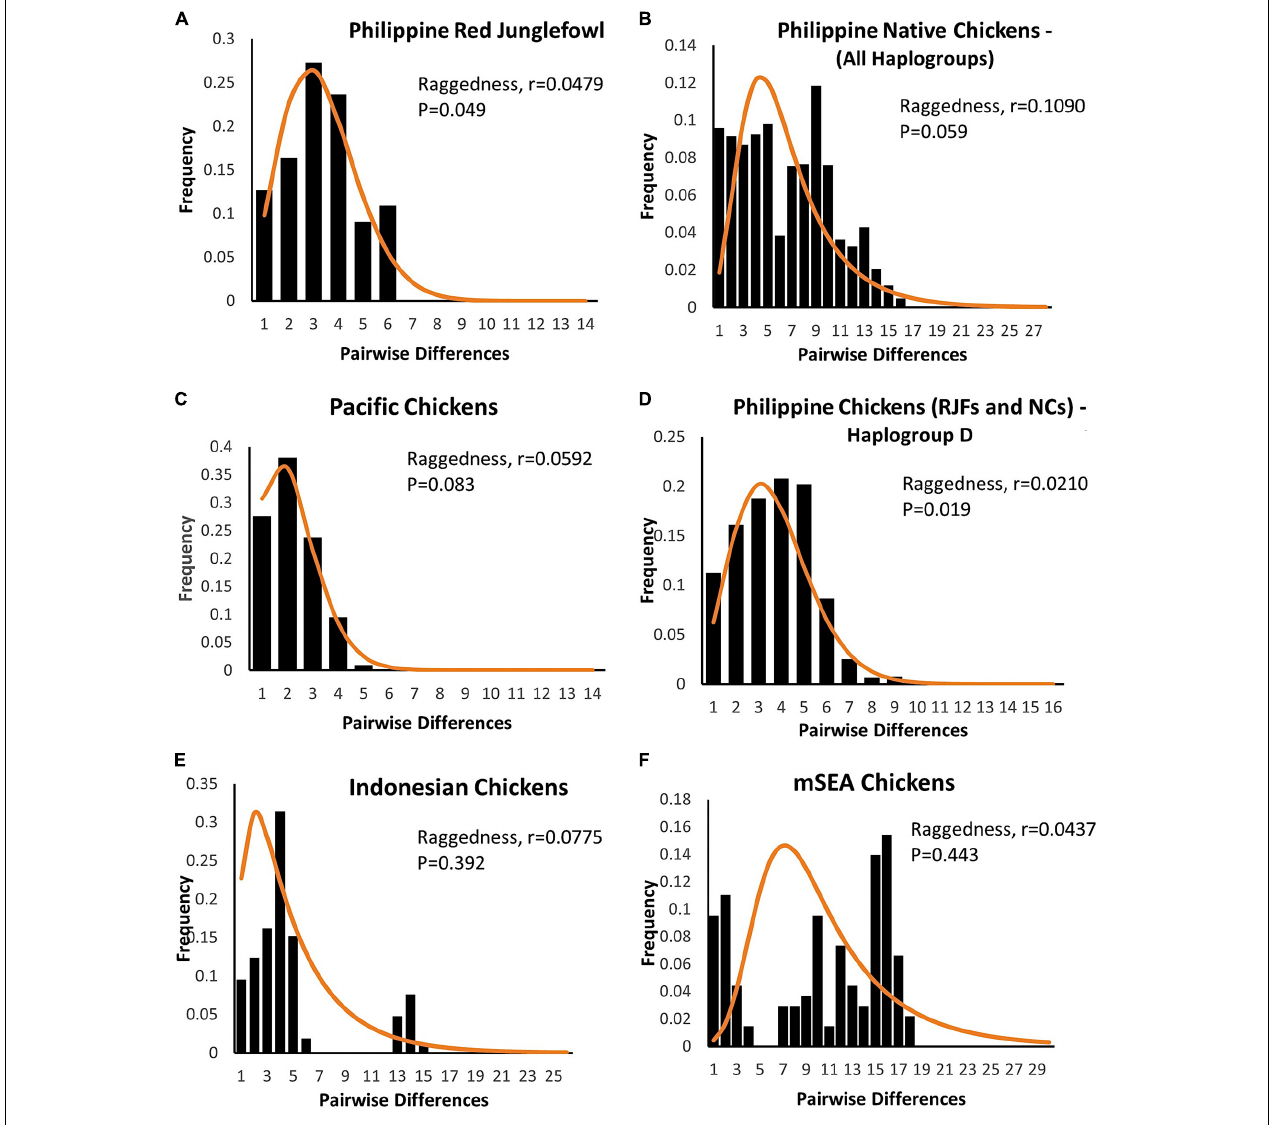
FIGURE 3 | Mismatch distribution of the complete mtDNA D-loop sequences of (A,B,D) Philippine chickens [red junglefowls (RJFs) and NCs], (C) Pacific, (E) Indonesian, and (F) mainland Southeast Asian (SEA) chickens based on pairwise nucleotide site differences. The solid line indicates the theoretical distribution under population expansion model. The raggedness statistics and corresponding p- values for (A) Philippine RJFs; r = 0.0479, p = 0.049 and (D) RJFs–NCs–haplogroup D; r = 0.0210, p = 0.019, provided statistical support for the smoothness of the observed